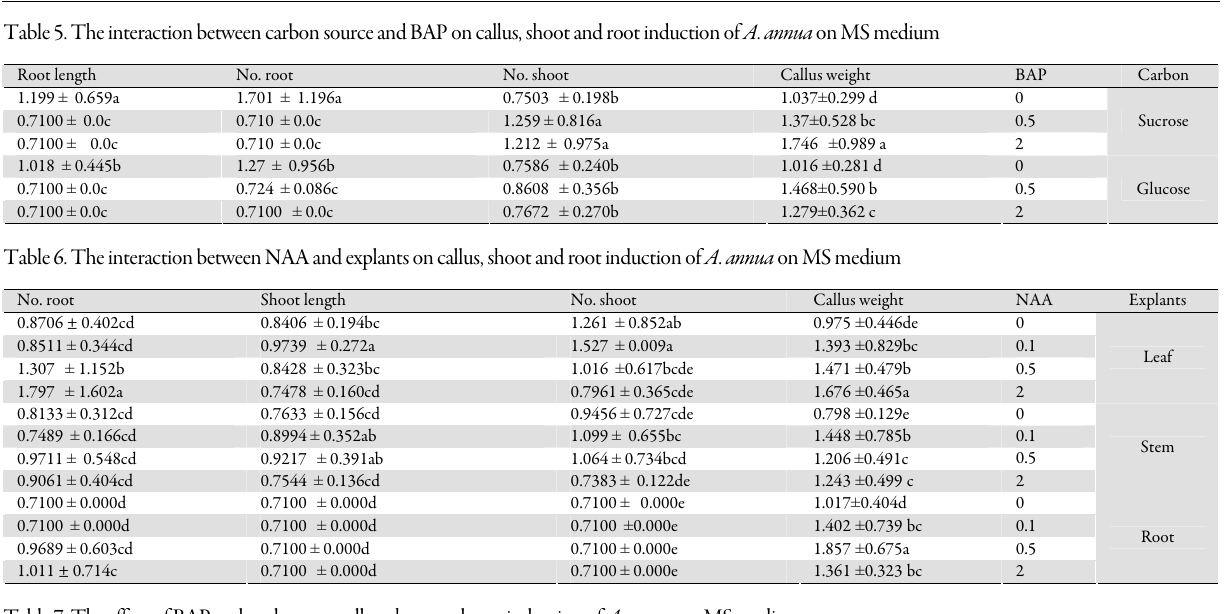
Table 7. The effect of BAP and explants on callus, shoot and root induction of A . annua on MS medium Root length